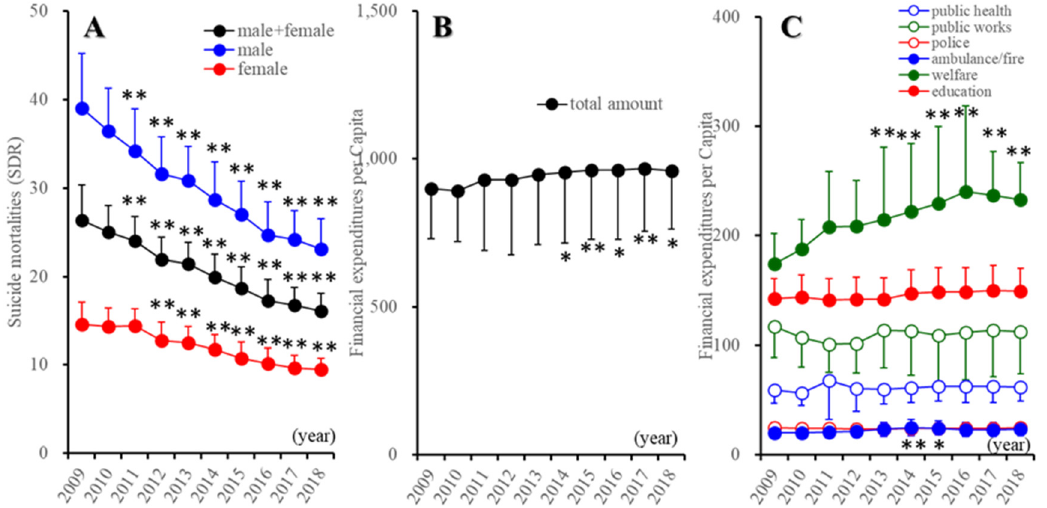
Figure 1. Trends of suicide mortalities ( A ), regional financial expenditure ( B , C ) in Japan from 2009 to 2018. ( A ) Ordinate, suicide mortalities per 100,000 population of males and females together, males, and females. ( B , C ) Ordinates, regional financial expenditure of prefecture and municipality (JPY 1000 per capita). * p < 0.05, ** p < 0.01: relative to 2009 by linear mixed model with Tukey’s post hoc test.